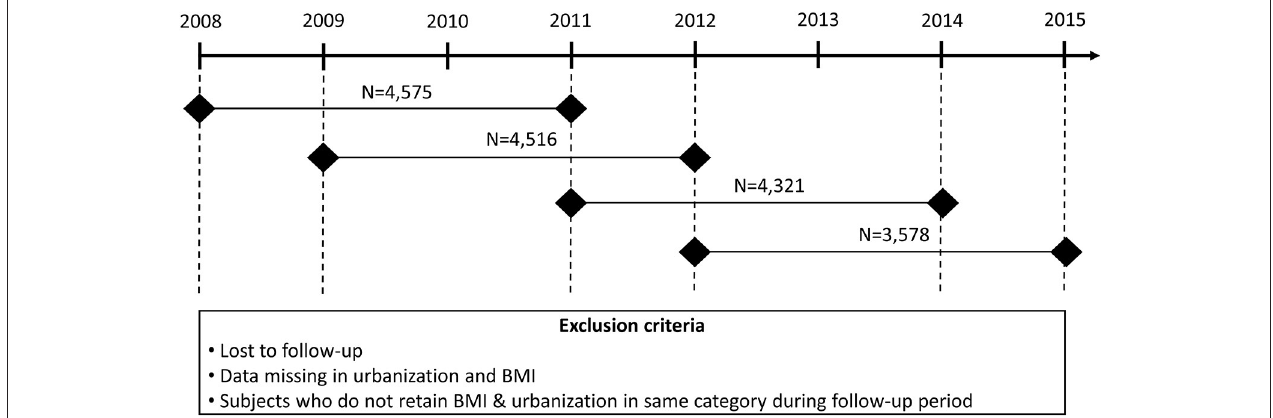
FIGURE 1 | The study cohort consisted of first and fourth graders in 2008, 2009, 2011, and 2012. We combined the data from two consecutive health examinations and urine analyses to ensure the validity of the BMI group, level of urbanization, proteinuria, and hematuria.